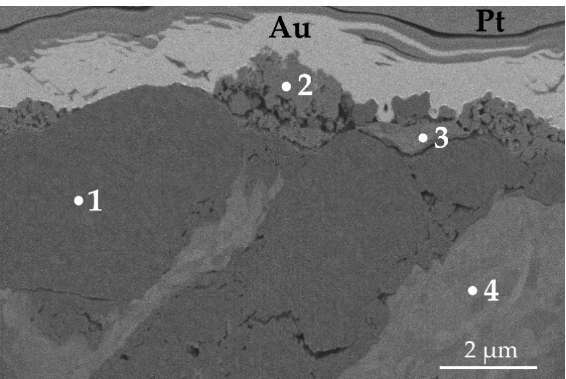
Figure 13. Backscattered electron SEM micrograph of the cross-section of a wear track, obtained on TiN-coated 440B stainless steel. The cross-section was done with the use of FIB. Au and Pt are the protective layers, used to prepare a cross-section with FIB.